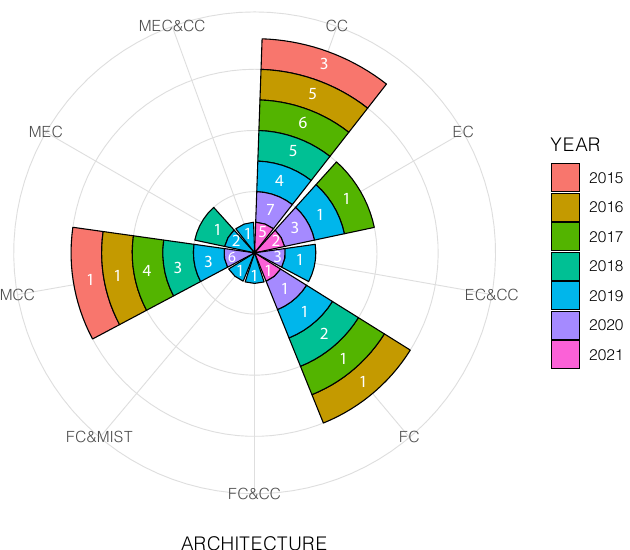
Figure 4. Use of computing paradigms per